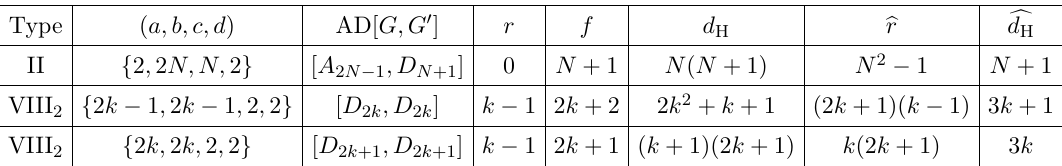
Table 10 . Basic data for the infinite series of SU( N ) trinions. Here ( a, b, c, d ) indicate the powers in the hypersurface equation. For the [ D ] series, which are given by type VIII N +1 , D N +1 singularities, or equivalently by type IV ( N, 2 , N, 2) singularities, we look at odd and even N separately. They all have ∆ A = 0 , b = 0 and trivial one-form r 3